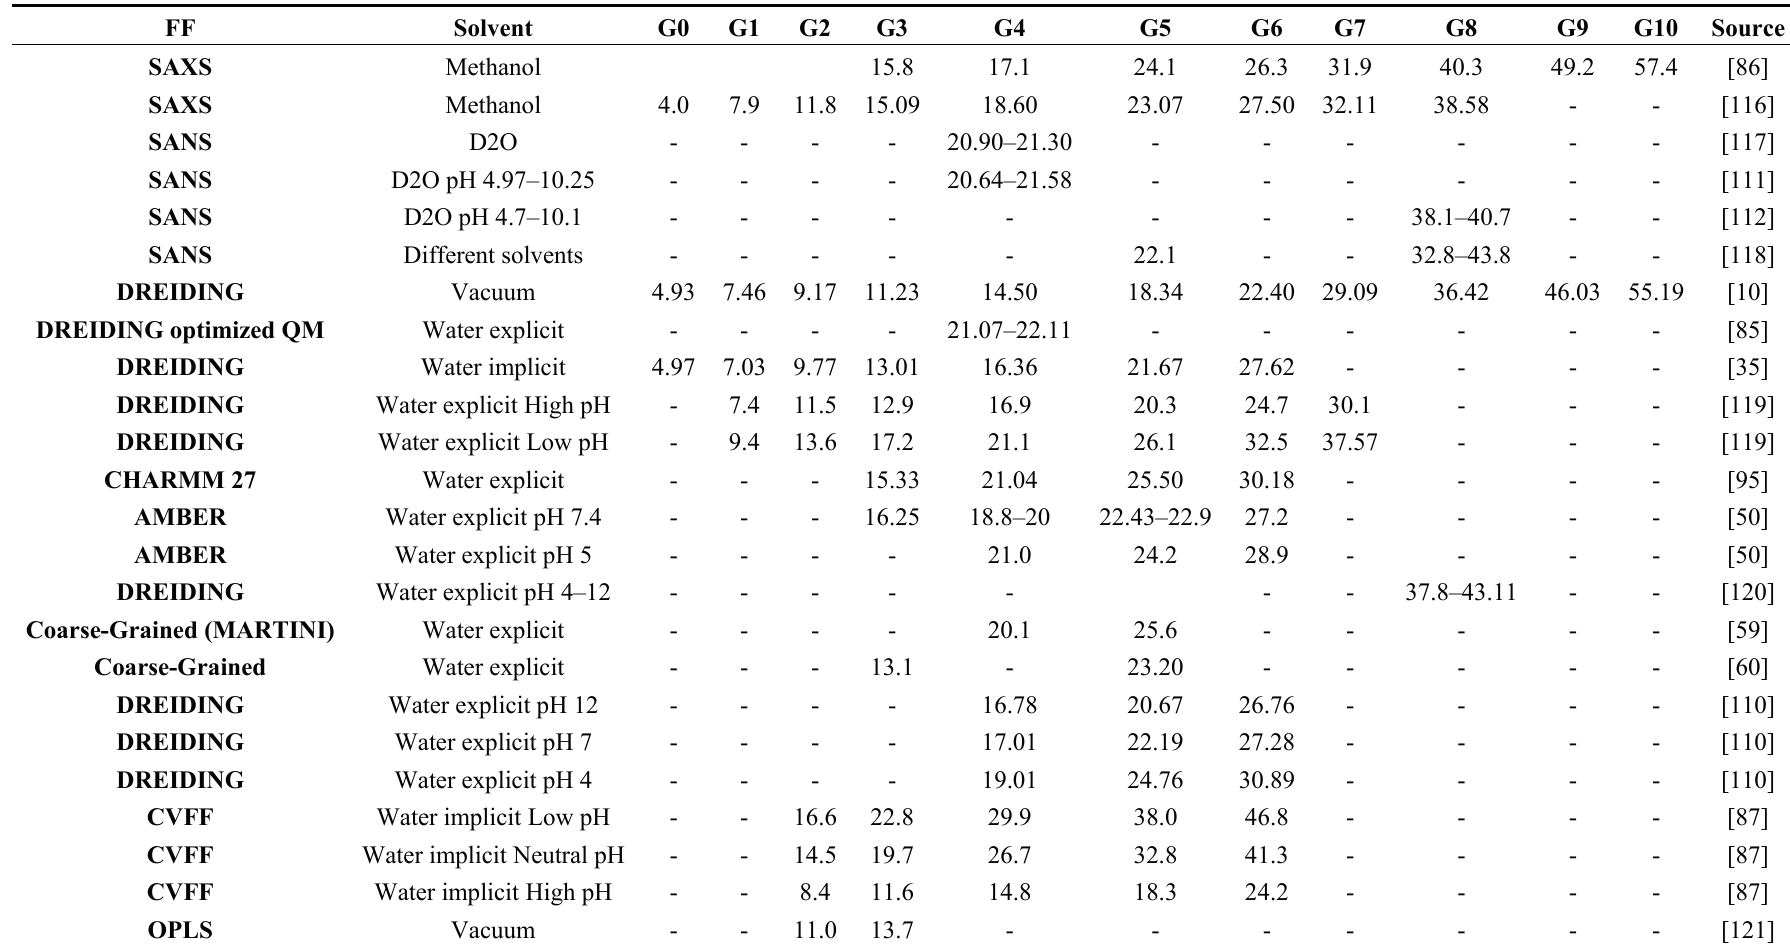
Table 2. Non exhaustive list of PAMAM dendrimer simulations and their radius of gyration. For comparison the experimental values obtained by SAXS and SANS are displayed on